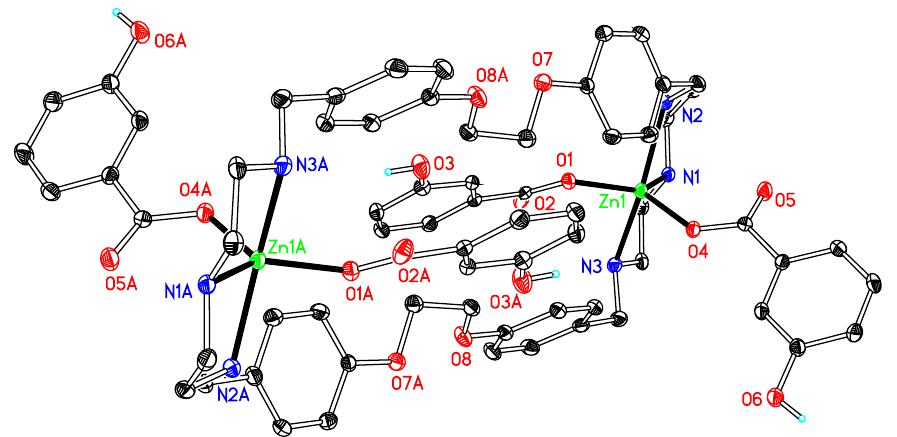
Figure 6. Thermal ellipsoid plot, drawn at the 50% probability level, of [Zn 2 ( m -OCOPhOH) 4 L 1 ] ( 6 ) with atomic numbering scheme. All H atoms, along with the solvents are omitted for clarity. Symmetry codes: A 2 − x, 1 − y, 1 − z. Selected bond lengths (Å) and angles ( ◦ ): Zn1–N1 2.063(3), Zn1–N2 2.298(2), Zn1–N3 2.275(2), Zn1–O1 1.994(2), Zn1–O4 1.953(2); N1–Zn1–N2 80.38(10), N2–Zn1–N3